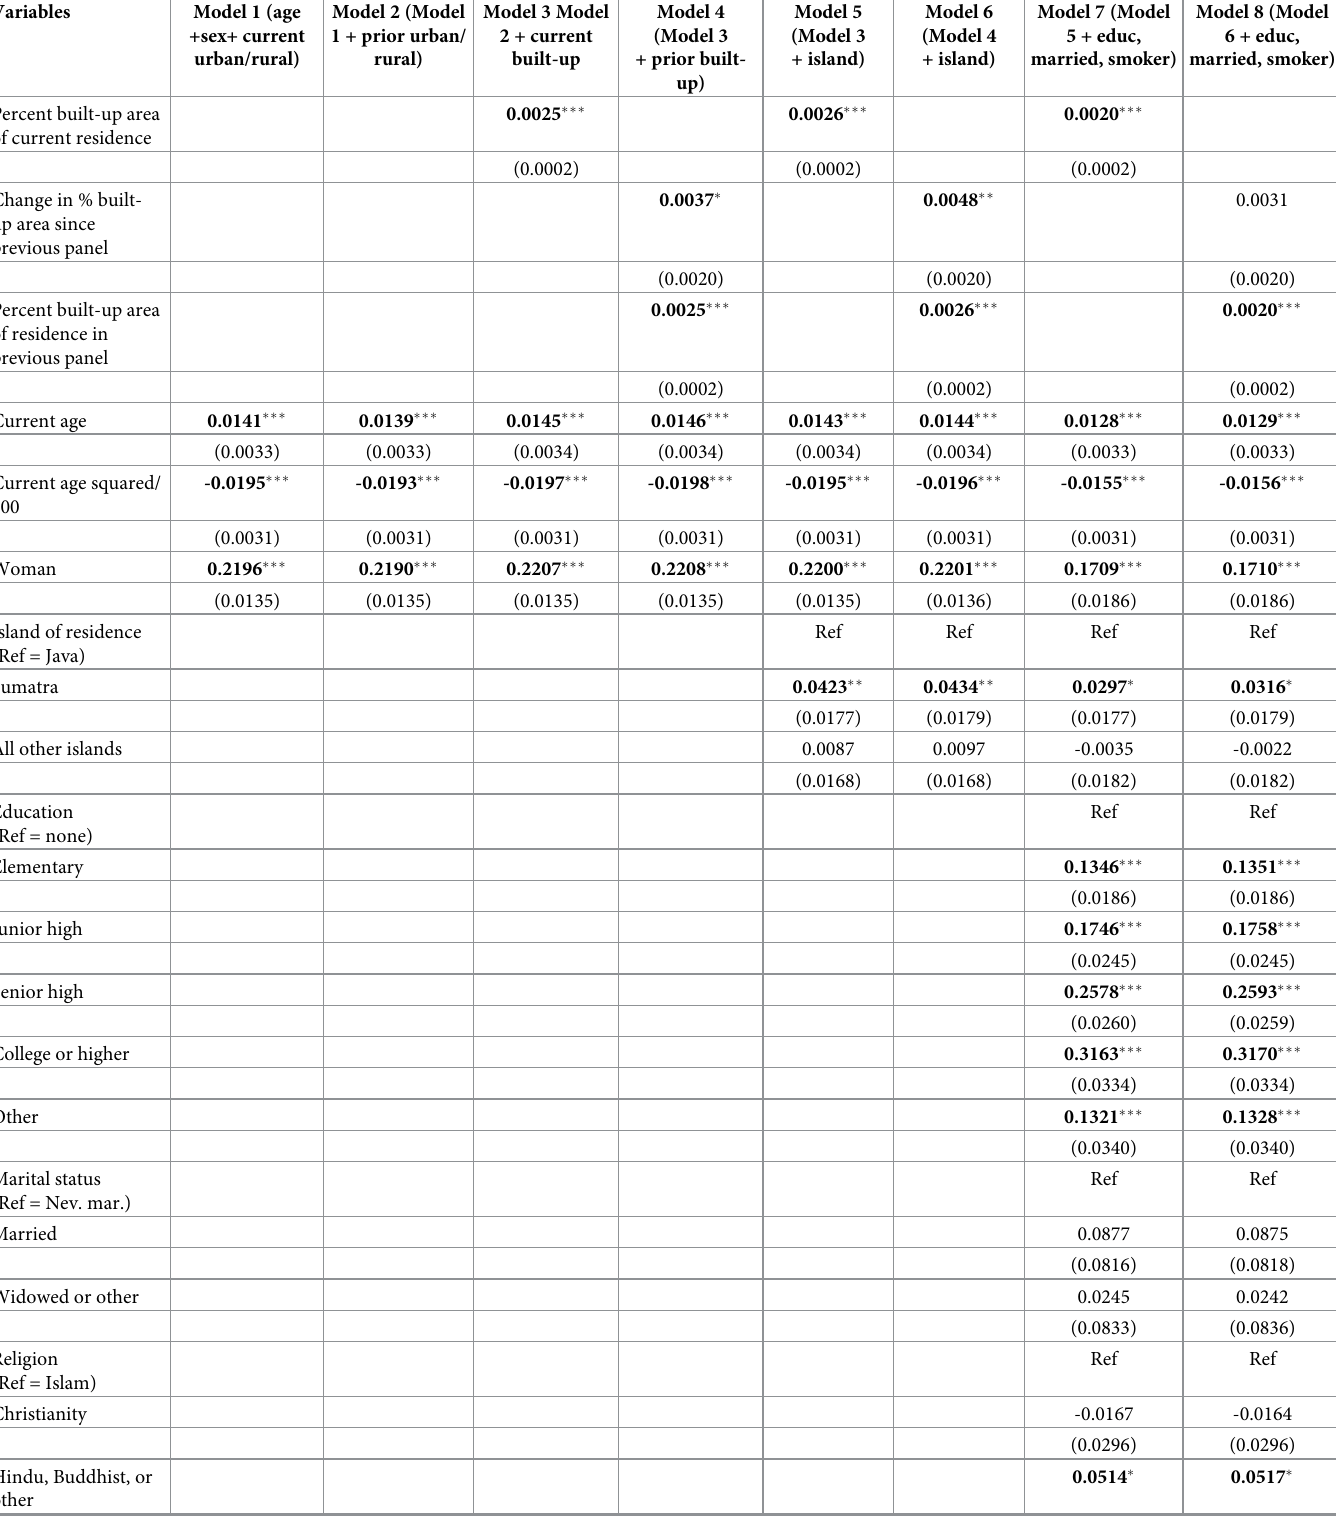
Table 5. Linear regression model predicting overweight/obese, pooled